Question: What style of plot is this figure drawn as?
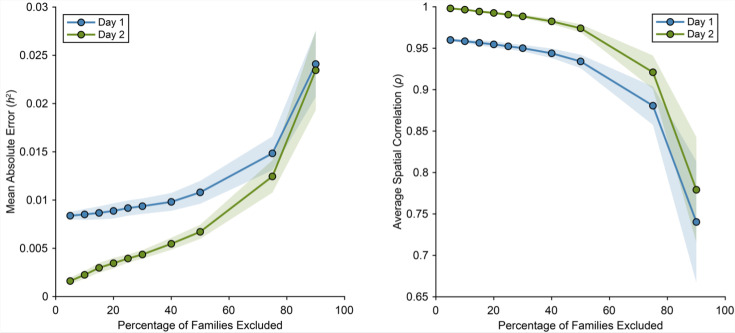
Answer: line